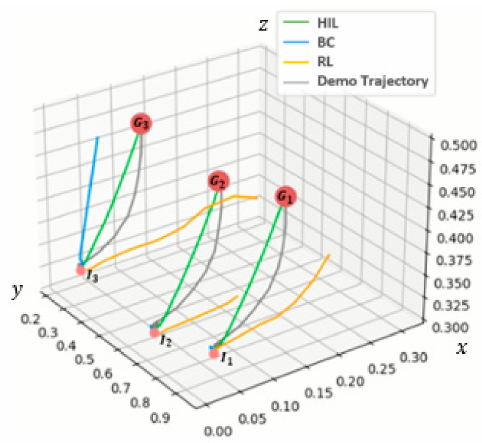
Figure 8. Qualitative comparison among the learned